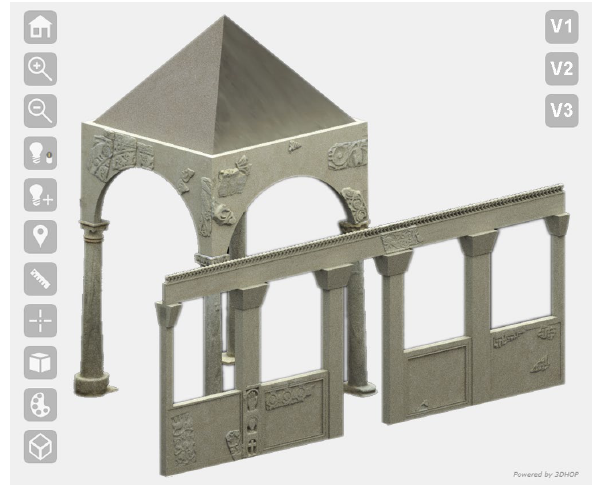
Figure 11. 3D model published with